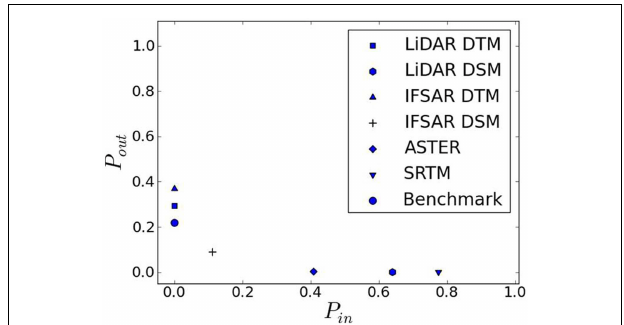
FIGURE 9 | P in and P out values for modeled results compared with observations of tsunami inundation from Tsuji et al. (1995) for the Wuring Peninsula (area of sketch shown in Figure 6) for ANUGA simulations.